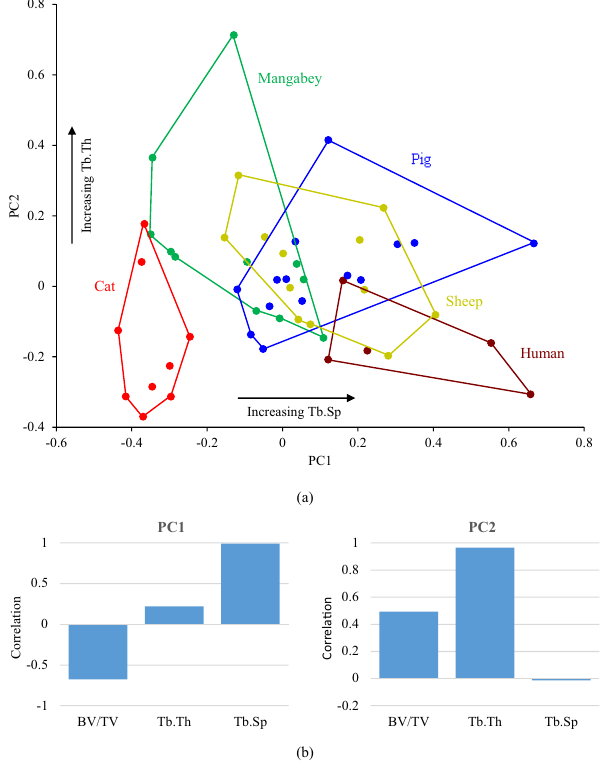
Figure 3. Results of ( a ) the PCA of three trabecular parameters within the RST bone, and ( b ) the correlation of the three measures to principal components 1 (PC1) and 2 (PC2).